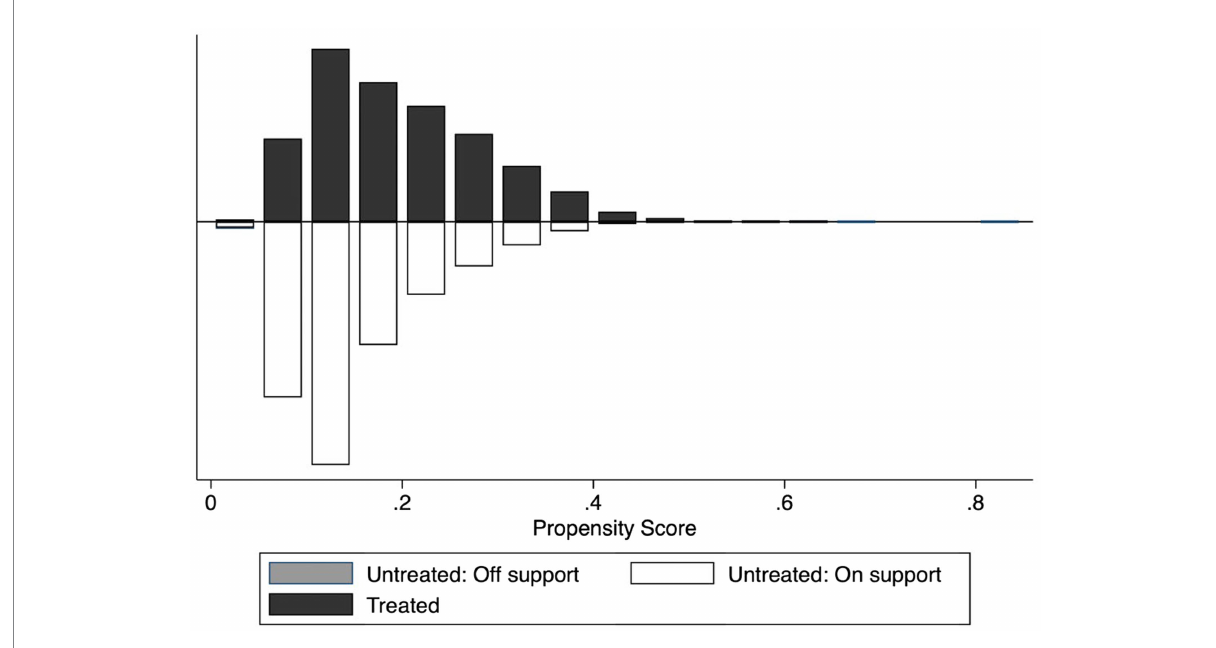
FIGURE 2 The region of common support between treated and untreated